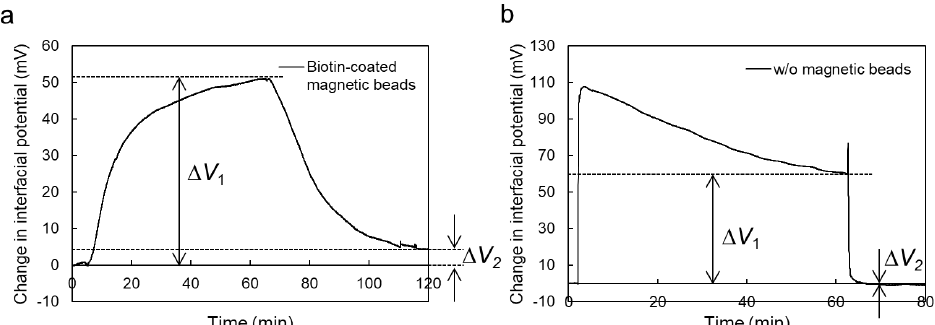
Figure 3. Real-time measurement of change in interfacial potential at solution/dielectric interface of MCC-based ISFET sensor. Biotin-coated magnetic beads were utilized for the detection of streptavidin using the MCC-based ISFET sensor [( a ) sample measurement], whereas an ISFET without magnetic beads was also prepared to estimate the effect of background noises such as the change in pH on the electrical signals of the MCC-based ISFET sensor [( b ) control measurement]. The volume and concentration of the injected streptavidin solution were 20 μL and 180 μM, respectively .